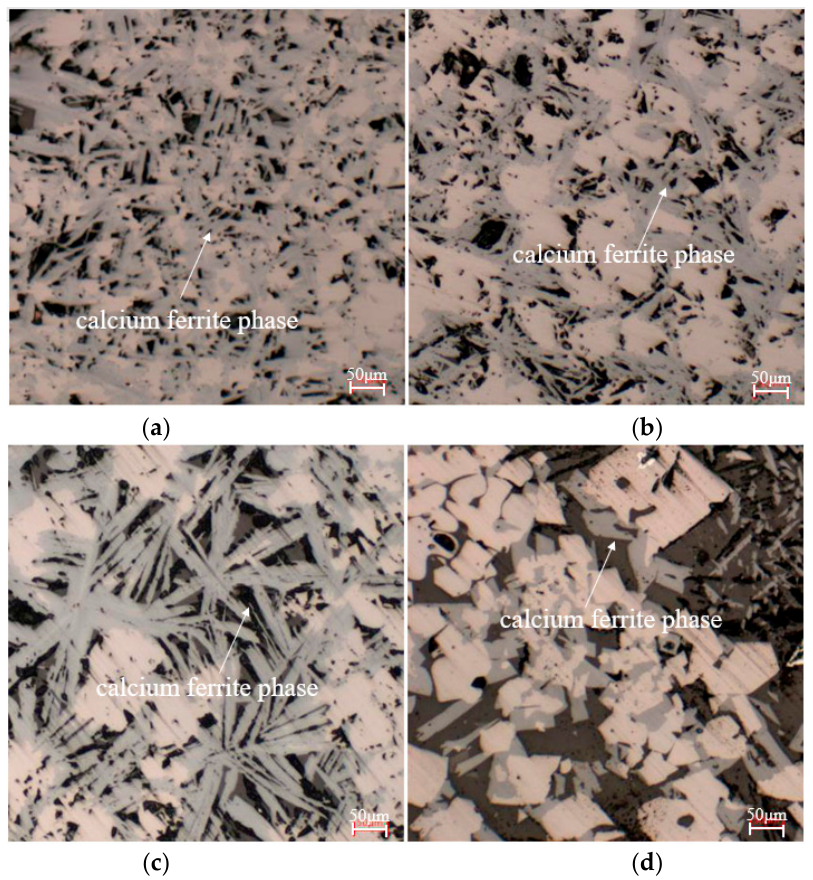
Figure 3. Mineralogical microstructure of sinter with different charcoal content. ( a ) 100% coke; ( b ) 20% charcoal; ( c ) 14% coke; ( d ) 60% coke.